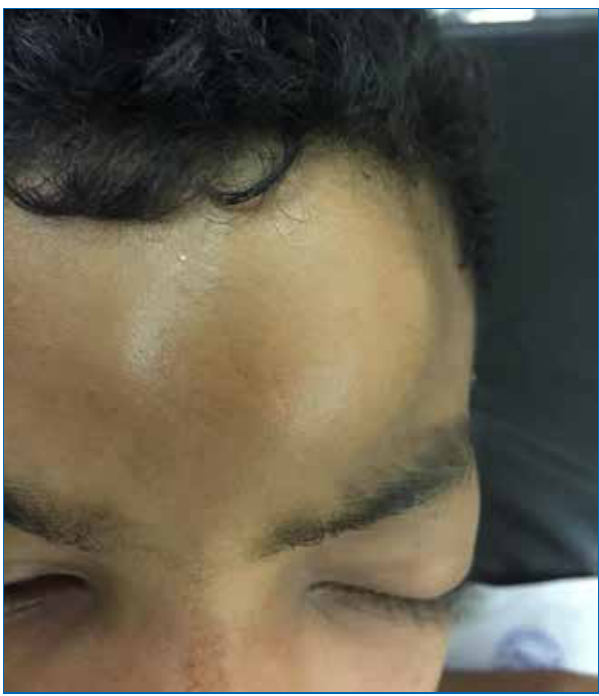
Figure 2. Contrasted CT Sinuses Coronal view demonstrating intracerebral abscess, maxillary sinusitis and subperiosteal abscess formation in the left